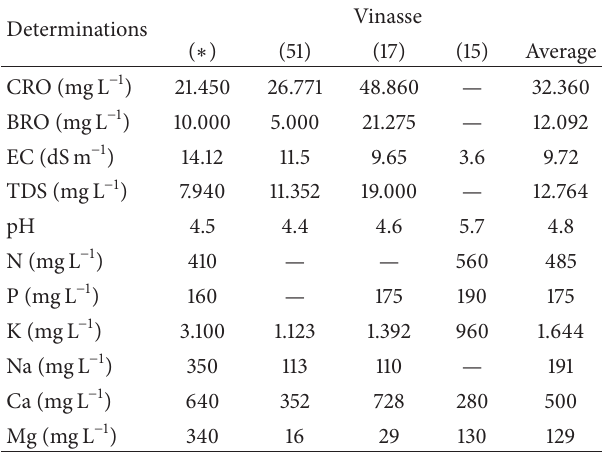
Table 3: The chemical requirements for oxygen (CRO), biological requirements for oxygen (BRO), electrical conductivity (EC), total dissolved solids (TDS), pH values, sodium and macronutrient concentrations of vinasse according to reports of various authors.